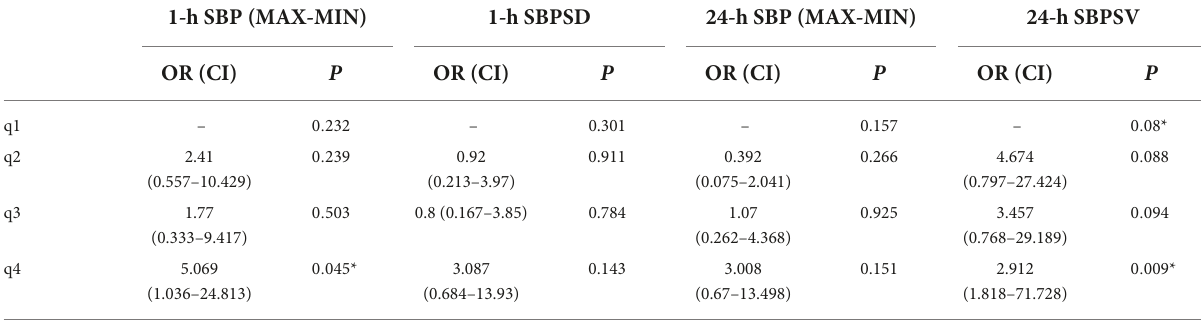
TABLE 3 Multivariate logistic regression analysis of the prediction of different interval BPV parameters for poor prognosis.